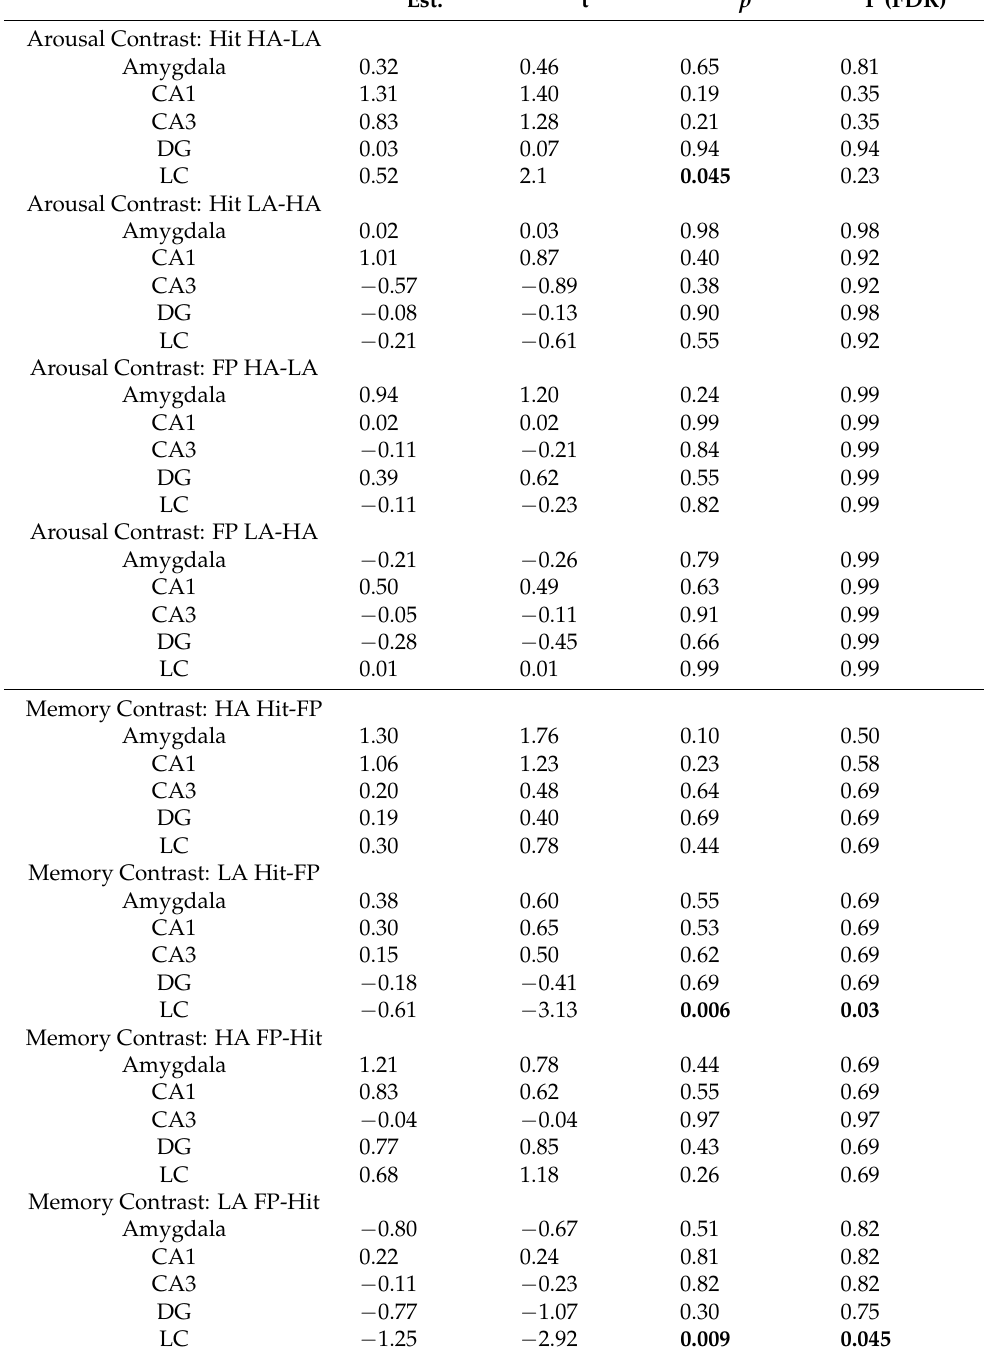
Table 3. Effect modification of worry on the association between activity (memory and arousal contrasts) and memory